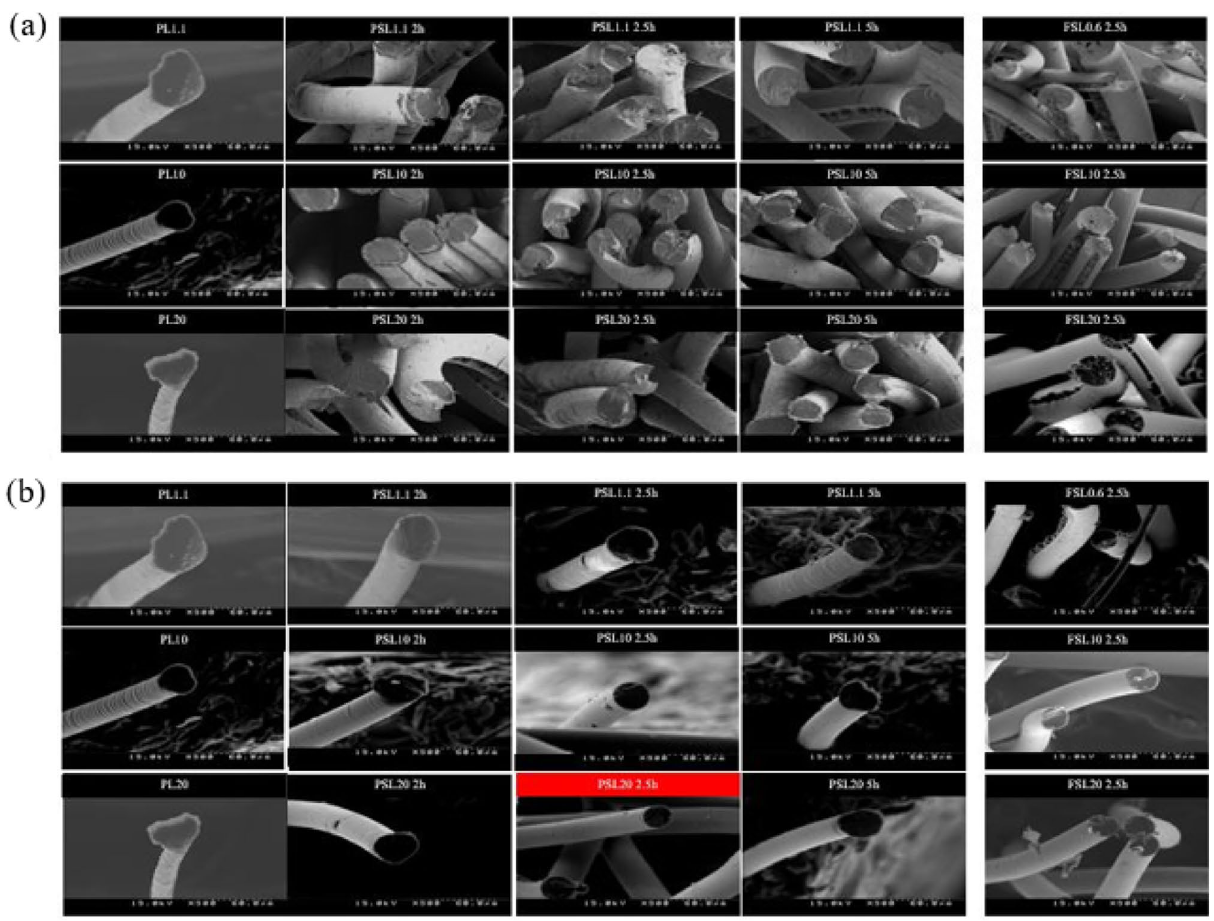
Figure 4. SEM images of the cross-sectional surface of the LLDPE fibers with a melt flow index of 1.1, 10, and 20 according to the sulfonation time under a pressure of 1 bar, 5 bar and temperature of 130 °C ( a ) Sulfonated fiber under 1 bar pressure, ( b ) Sulfonated fiber under 5 bar